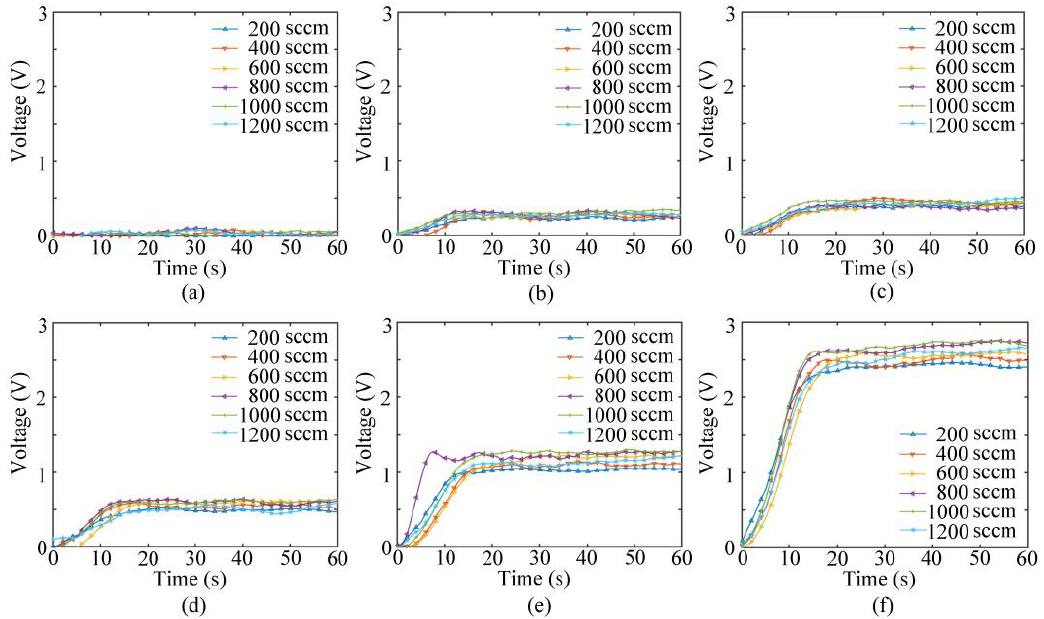
Figure 8. Voltage value response diagrams of bionic electronic nose system: ( a ) 5 ppb, ( b ) 25 ppb, ( c ) 35 ppb, ( d ) 50 ppb, ( e ) 100 ppb, and ( f ) 200 ppb.